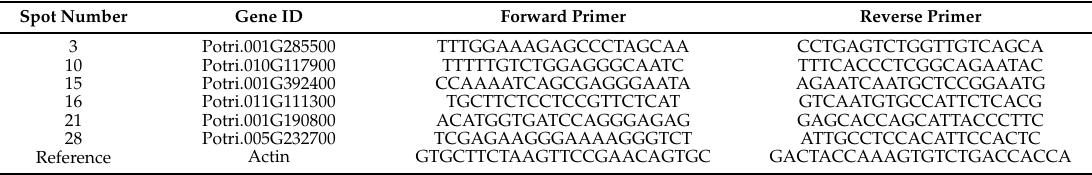
Table A1. The sequences of qRT-PCR